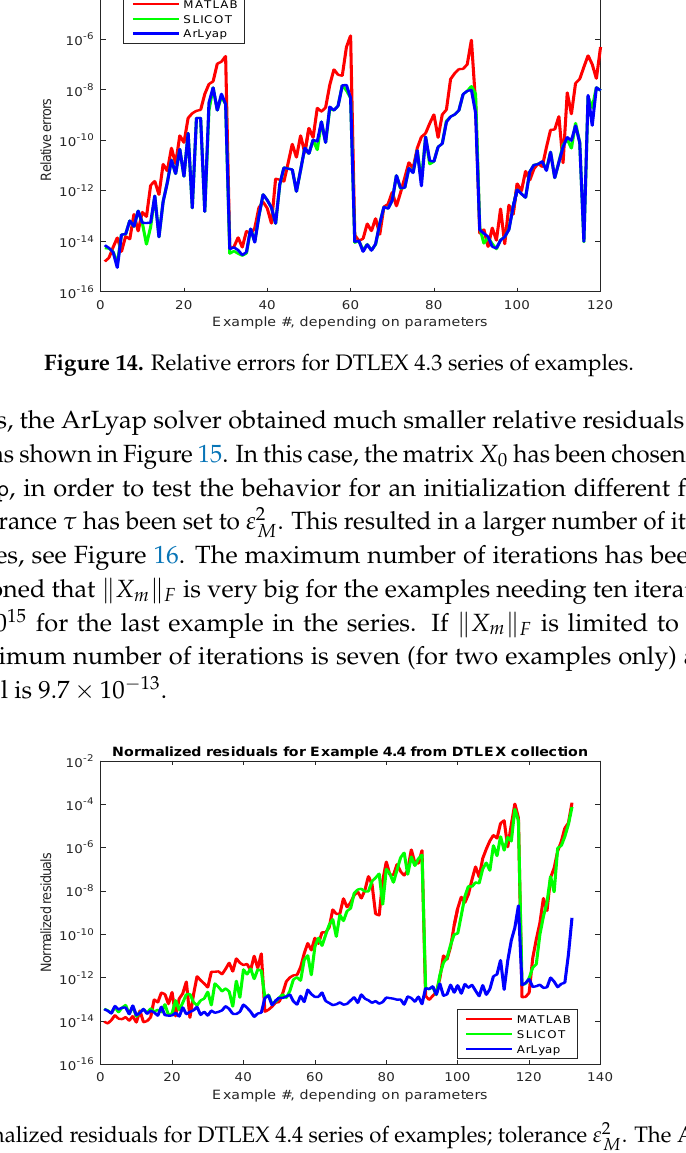
. The ArLyap solver is M